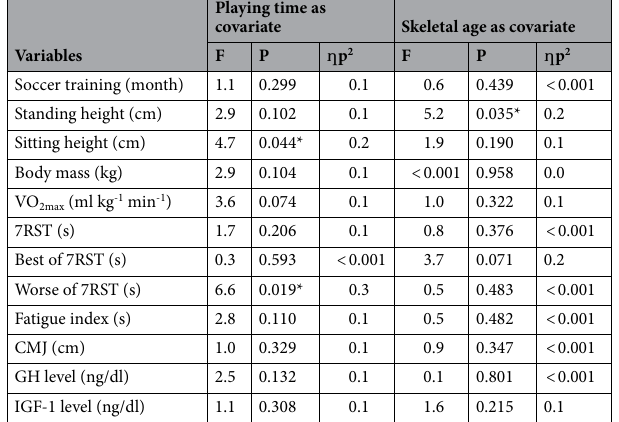
Table 3. Results of MANCOVA to control playing time and maturation level of under 15 youth football players.